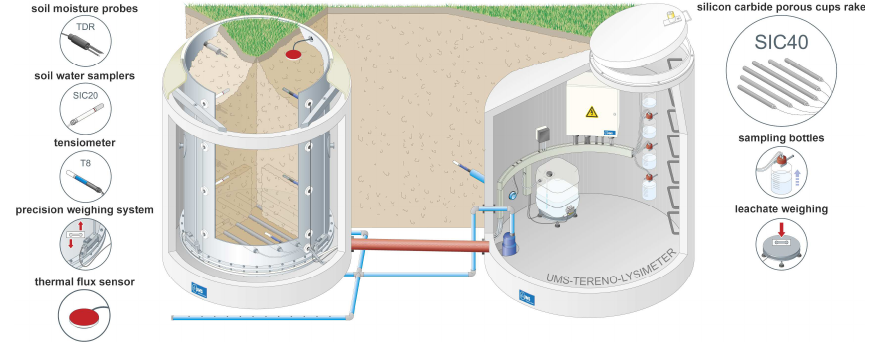
Figure 3. Schematic drawing of the lysimeter soil monolith (left) and service well (right) used in the TERENO-SoilCan project. The illus- tration of the lysimeter (left) shows the weighted soil column container with slots for soil moisture (TDR), temperature (SIS, TS1), matric potential sensors (SIS), soil water sampler (SIC20), and silicon porous suction cup rake (SIC40) installation inside and outside the monolith. The service well contains the weighted drainage tank and sampling tubes for each affiliated lysimeter (courtesy of UMS GmbH Munich, 2014, used by